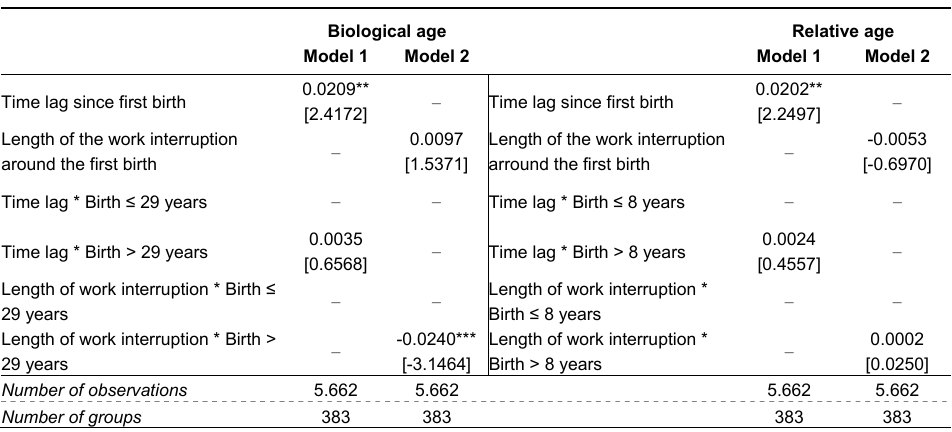
Fixed-effects results based on the relative and biological age at first birth (  -coefficient, t-values in